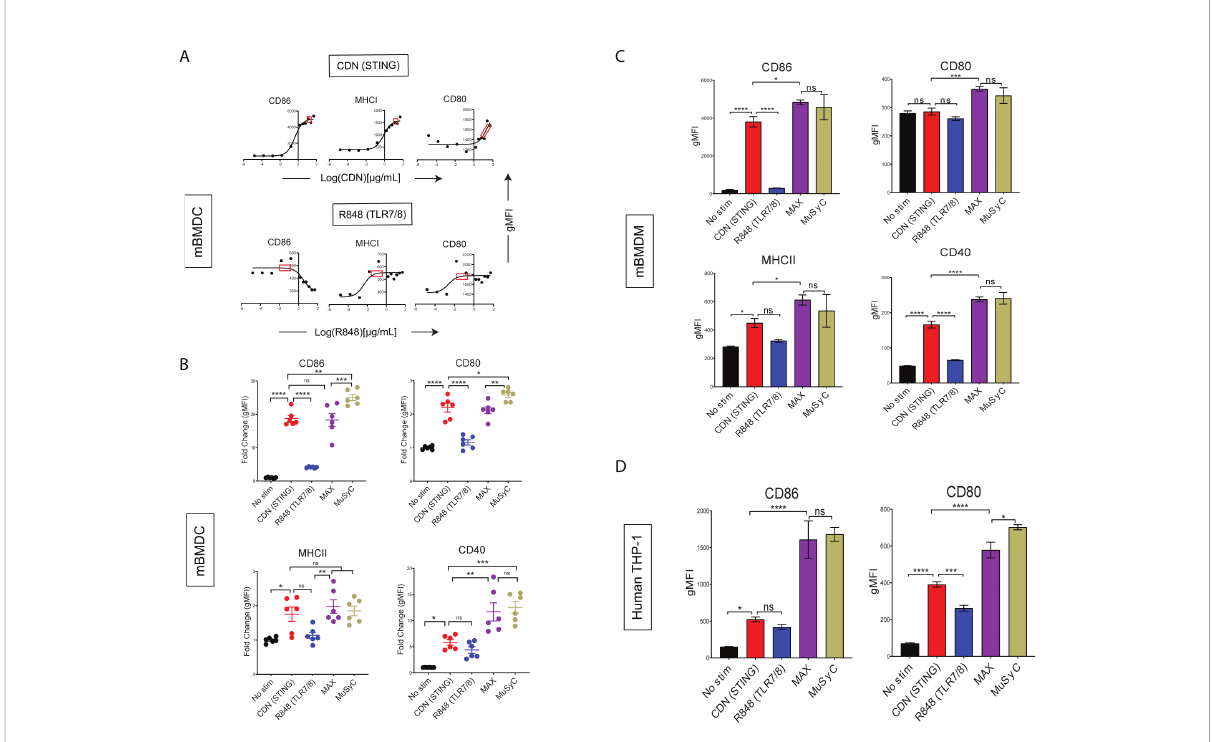
FIGURE 2 MuSyC-dose can optimize activation for multiple APCs in vitro. (A) Corresponding dose-response curves for CDN (STING) and R848 (TLR7/8) for the activation of mBMDCs with the saturation range for each adjuvant in the red box. 20 µg/ml was chosen for CDN and 0.1 µg/ml was chosen for R848. (B) mBMDCs activated with R848, CDN, Max-dose (CDN of 20 µg/ml + R848 of 0.1 µg/ml), and MuSyC-dose (20 µg/ml + R848 of 0.01 µg/ml). The fold change gMFI normalized to the average no stim control of the activation markers are shown. (C) Murine bone marrow – derived macrophages (mBMDM) activation with the doses selected through the corresponding dose-response (Supplementary Figure 4A). (D) Human monocytic cell line (TH-P1) activation with appropriate doses (Supplementary Figure 4B). Figure 2B is given in mean ± SEM for two independent experiments. All other data are given in mean ± S.D. of three technical replicates. *P < 0.05, **P < 0.01, ***P < 0.001, and ****P < 0.0001; one-way analysis of variance (ANOVA) for multiple comparisons. ns, not signi fi